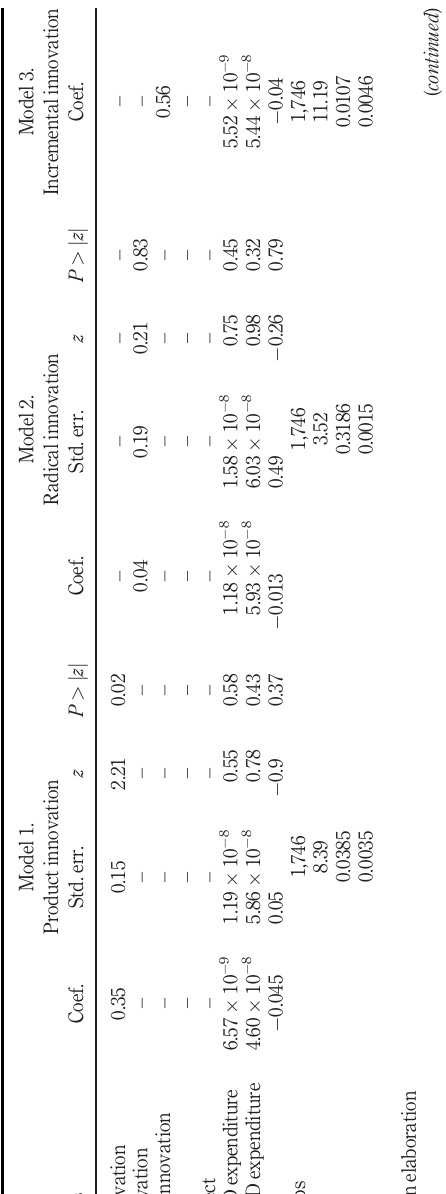
Table 2. Dependent variable